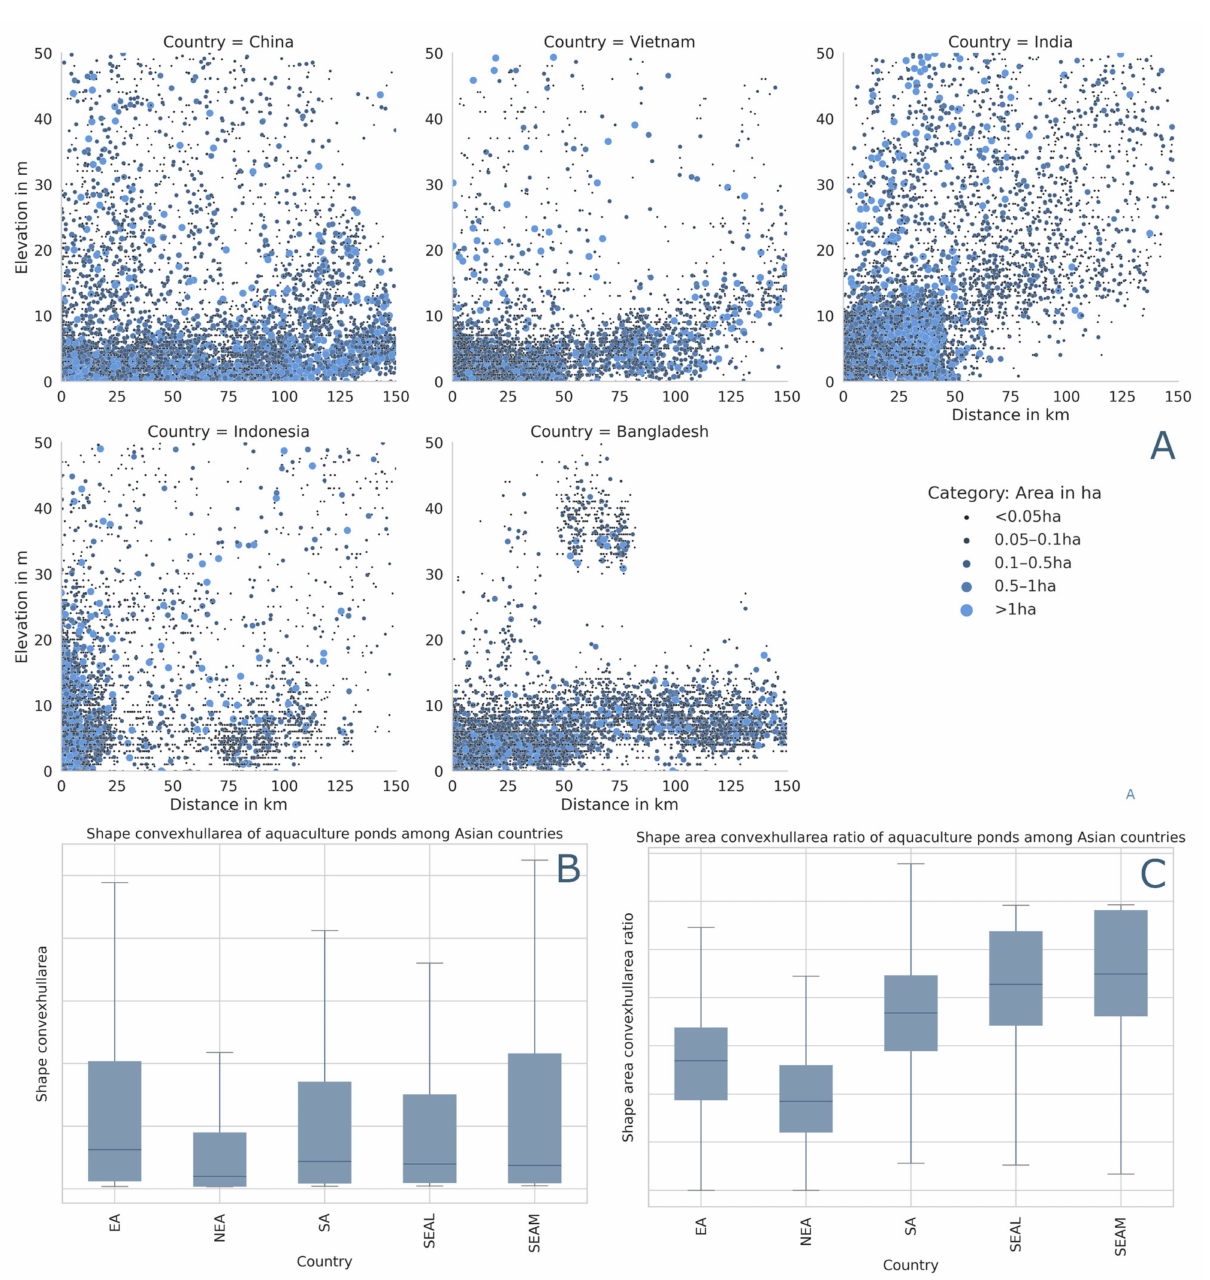
Figure 13. Scatterplots of elevation and distance of aquaculture categorized among different pond sizes for the top 5 Asian countries (China, Indonesia, India, Vietnam, and Bangladesh) ( A ); Boxplots of the area of the convex hull ( B ) and the ratio between the pond area and its convex hull ( C ) for the mapped ponds from the five defined macro-regions East Asia (EA), Northeast Asia (NEA), South Asia (SA), Southeast Asia Mainland (SEAL), and Southeast Asia Maritime